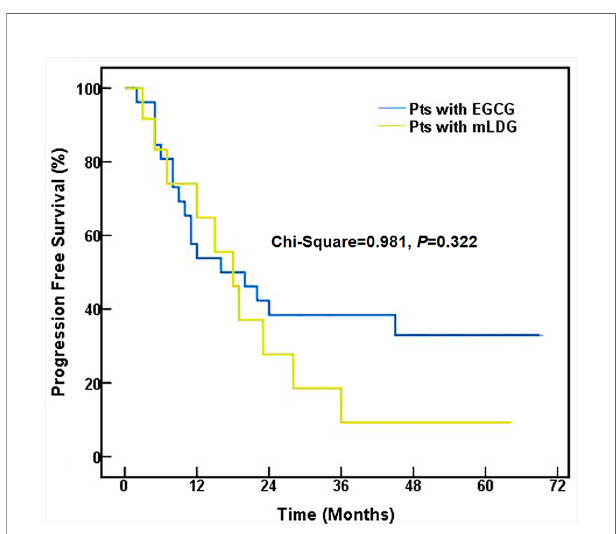
FIGURE 3 | Progression-free survival of SCLC patients (pts) treated with EGCG (blue) or mLDG (gold)